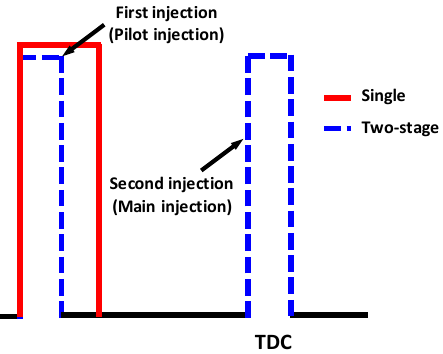
Figure 2. Single and two-stage early injection strategy.